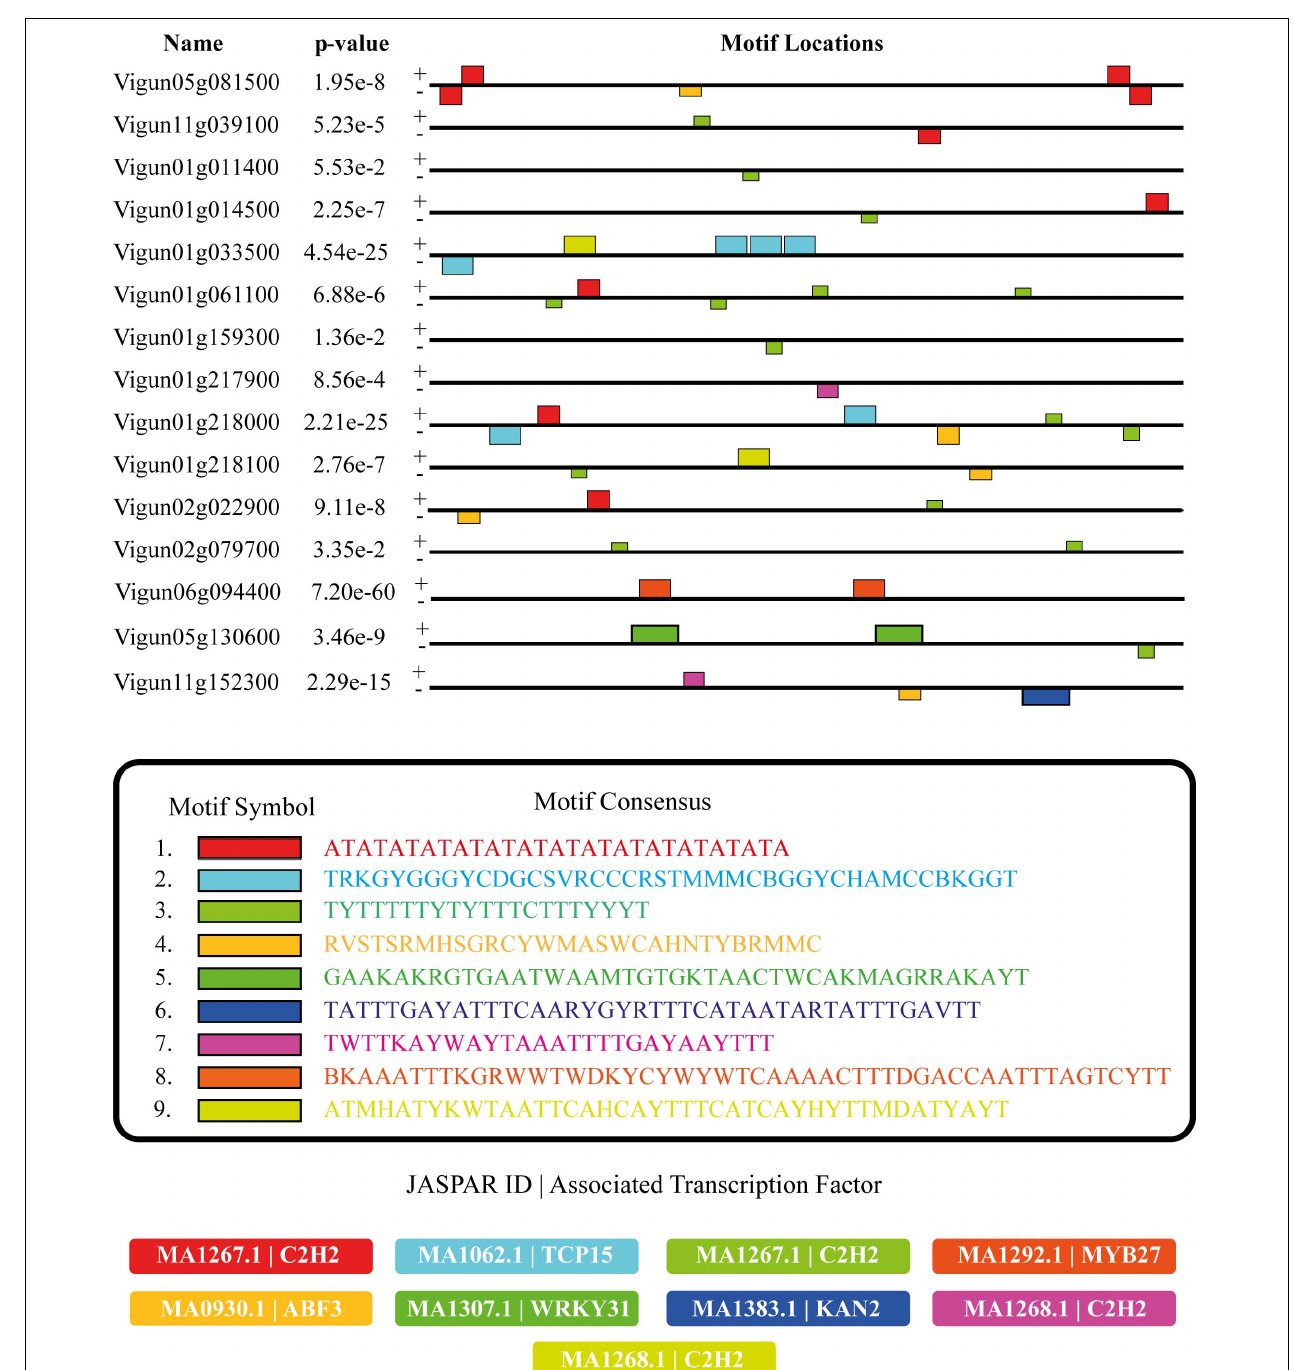
FIGURE 6 | Distribution (colored rectangles) of enriched bona fide CCREs anchored in the promoter regions (black lines) of a sample (the plotted gene sample was deliberately chosen to present all the enriched bona fide CCRE types found in the complete set of promoters analyzed) of genes encoding RLK-Pelle_DLSV bona fide VuPKs as well as information on their motif consensus and associated transcription factors (Matrix JASPAR ID). CCREs, candidate cis -regulatory elements. Plus (+) and minus (–) signs indicate sense and antisense DNA strands of the analyzed promoter